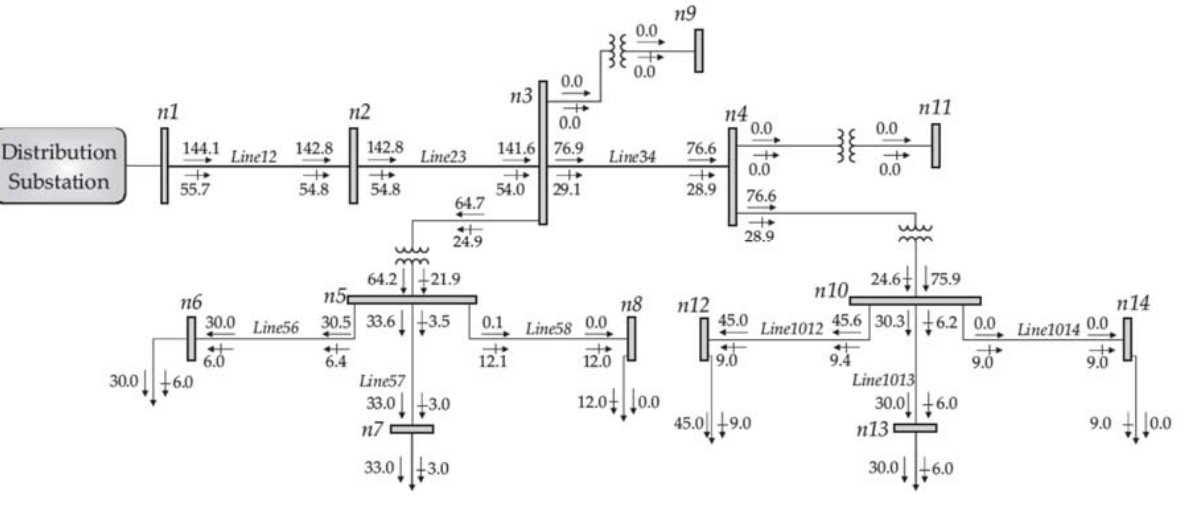
Figure 11. Three ‐ phase complex power flow diagram for the base case.